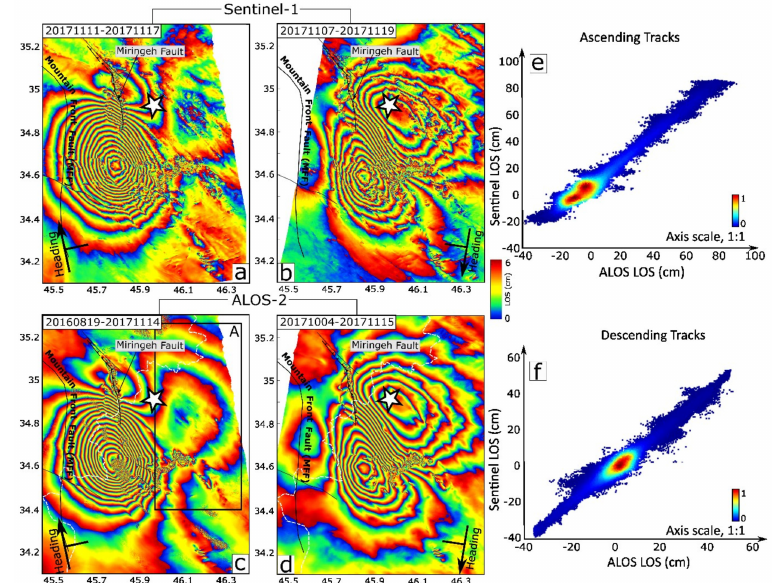
Figure 2. Coseismic interferograms resulting from ( a , b ) Sentinel-1 C-band and ( c , d ) ALOS-2 L-band data. All interferograms were unwrapped and rewrapped again with each fringe representing 6 cm of ground deformation in the LOS direction. The white star shows the location of the main shock suggested by the USGS. ( e , f ) Scatter plots showing the correlation between Sentinel-1 and ALOS-2 data for ascending and descending geometry, respectively; the color bar corresponds to the density number of each point in the scatter plot (0—lowest density; 1—highest